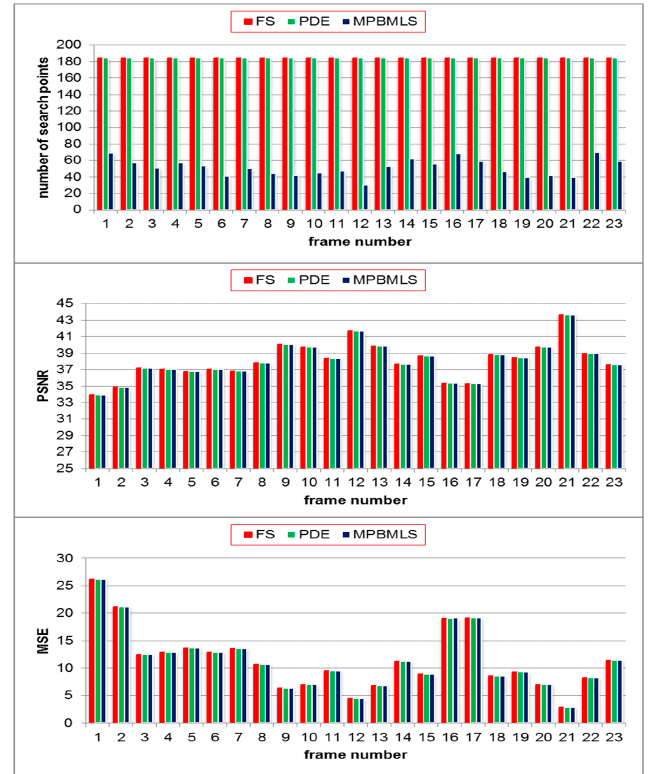
Figure 6. Average number of search points per MB, peak signal-to-noise ratio (PSNR) performance, and mean square error (MSE) of MPBMLS, full search (FS), and partial distortion elimination (PDE) for the “Claire” video sequence of 23 frames. Remote Sens. 2020 , 12 , x FOR PEER REVIEW